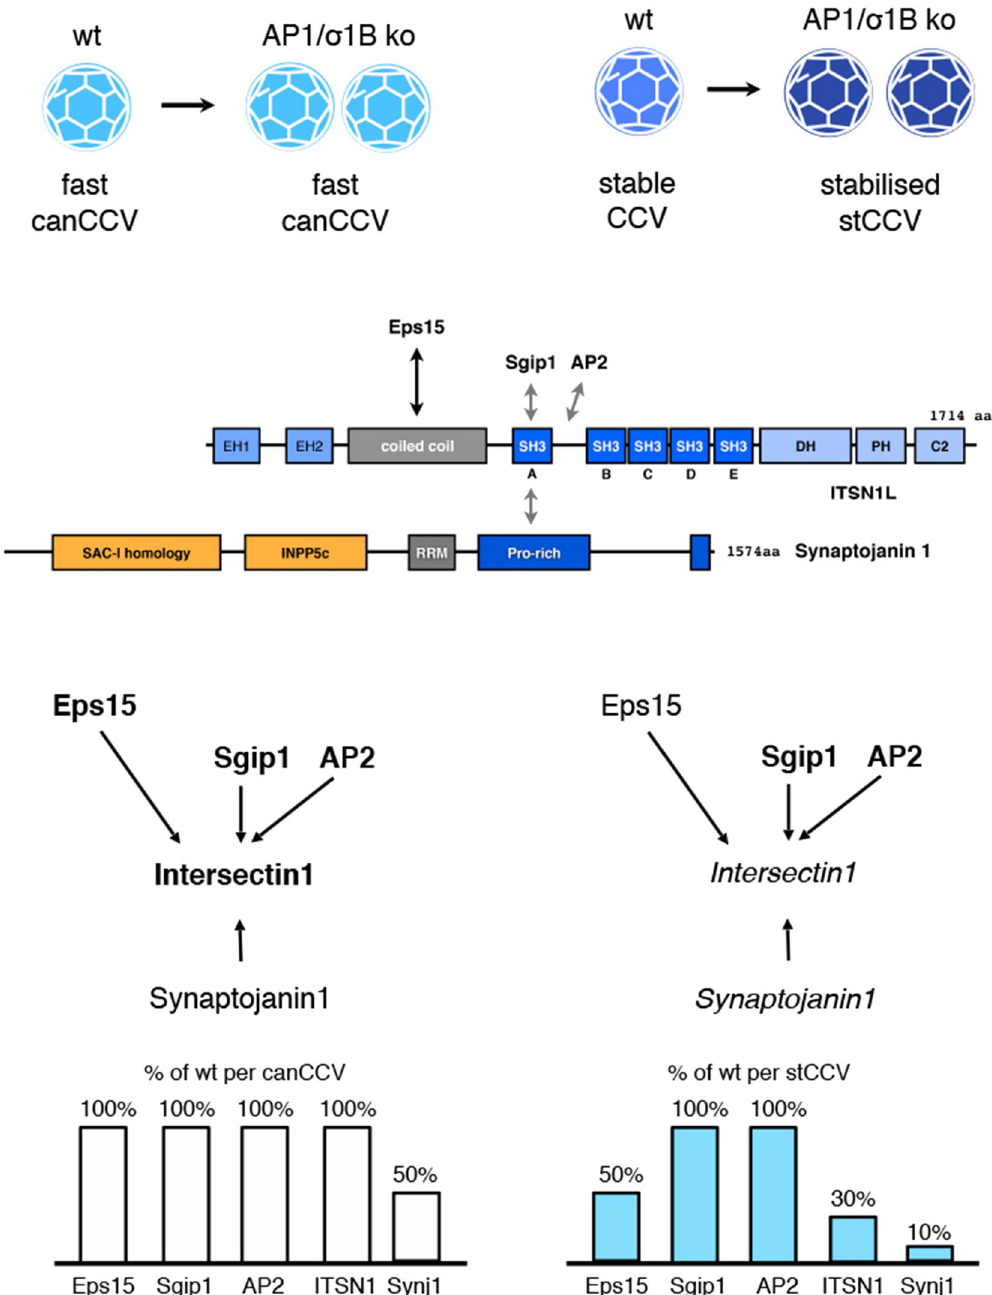
Figure 7. Model of protein–protein interactions determining the amount of synaptojanin1 stably incorporated into canCCV (left) and stCCV (right). Eps15 determines ITSN1 levels and the competition of Sgip1/AP2 and synaptojanin1 for ITSN1 determines synaptojanin1 levels. Interaction scheme: proteins in bold letters are present at 100% of wt levels, proteins in regular letters are reduced to 50% of wt levels, proteins in italics are reduced below 50% of wt levels. Please refer to the “Results” and “Discussion” sections for more